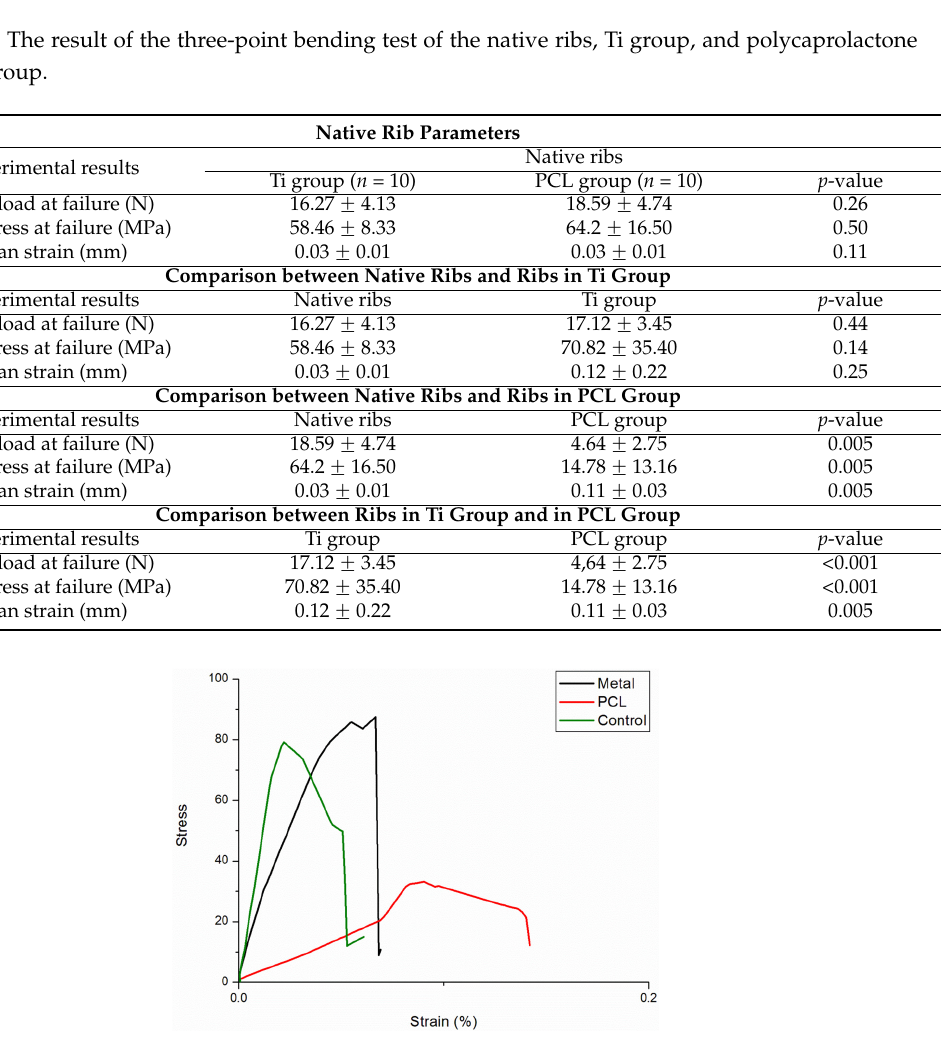
Figure 4. The stress-strain curves of the native ribs (green), Ti-group (black), and PCL group (red). The ribs in the Ti group can support the highest stress; the ribs in the PCL group can support the lowest stress with the highest